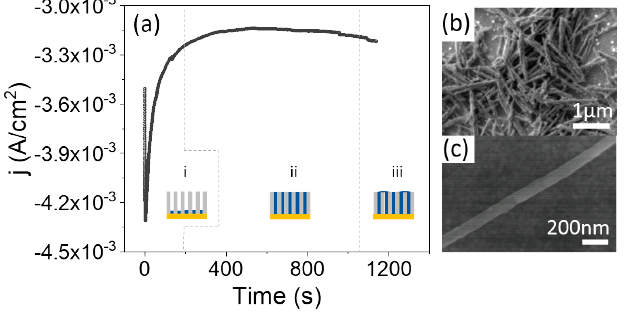
Figure 3. ( a ) Evolution of current density with time during the electrodeposition of CoFe NWs in a nanoporous alumina template. Three characteristic regions can be distinguished: (i) nucleation, (ii) NWs growth and (iii) overgrowth. ( b , c ) are SEM images of CoFe NWs at two different magnifications.